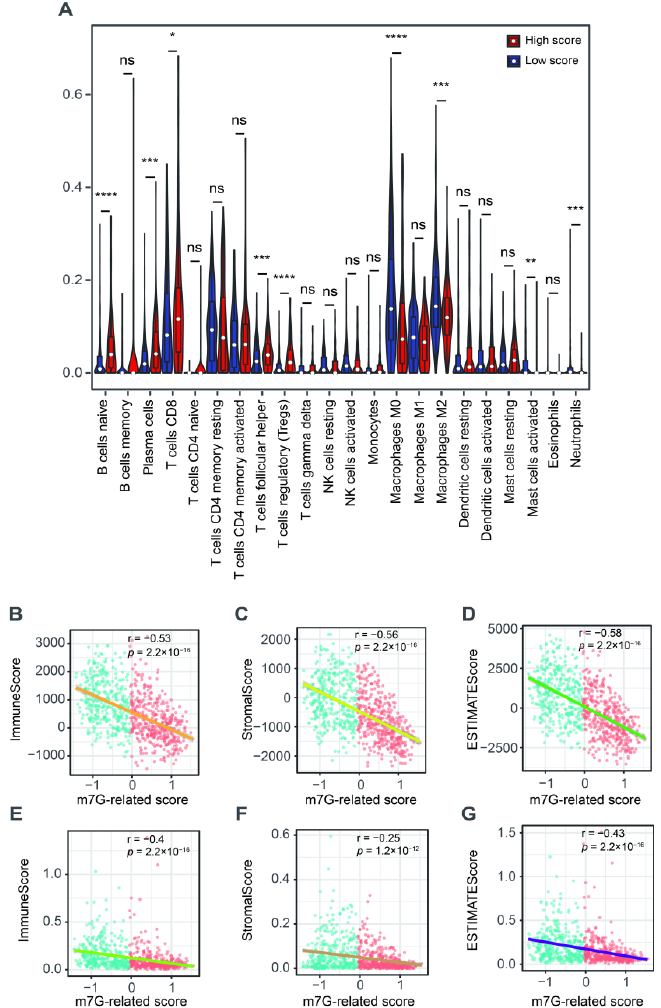
Figure 6. The relationship between m7G-related signature and tumor microenvironment. ( A ) The abundance of 22 tumor-infiltrating immune cells between high- and low-score groups. ( B ) The correlation analysis between immune scores and m7G-related scores via “ESTIMATE” algorithm. ( C ) The correlation analysis between stromal scores and m7G-related scores via “ESTIMATE” algo- rithm. ( D ) The correlation analysis between estimate scores and m7G-related scores via “ESTIMATE” algorithm. ( E ) The correlation analysis between immune scores and m7G-related scores via “xCell” algorithm. ( F ) The correlation analysis between stromal scores and m7G-related scores via “xCell” algorithm. ( G ) The correlation analysis between estimate scores and m7G-related scores via “xCell” algorithm. Data in ( A ) were analyzed by Wilcoxon test; ns, no significance; * p < 0.05, ** p < 0.01, *** p < 0.001 and **** p < 0.0001.